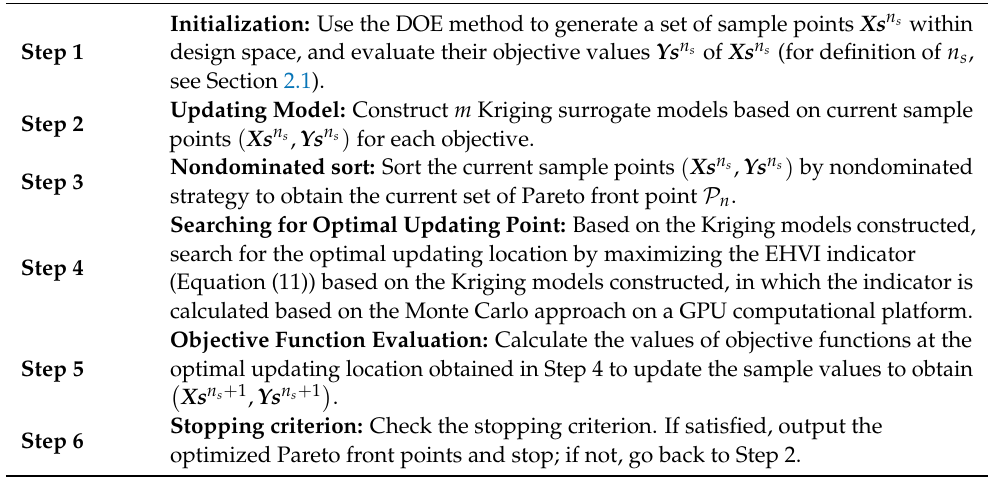
Algorithm 4. GMOEGO Algorithm